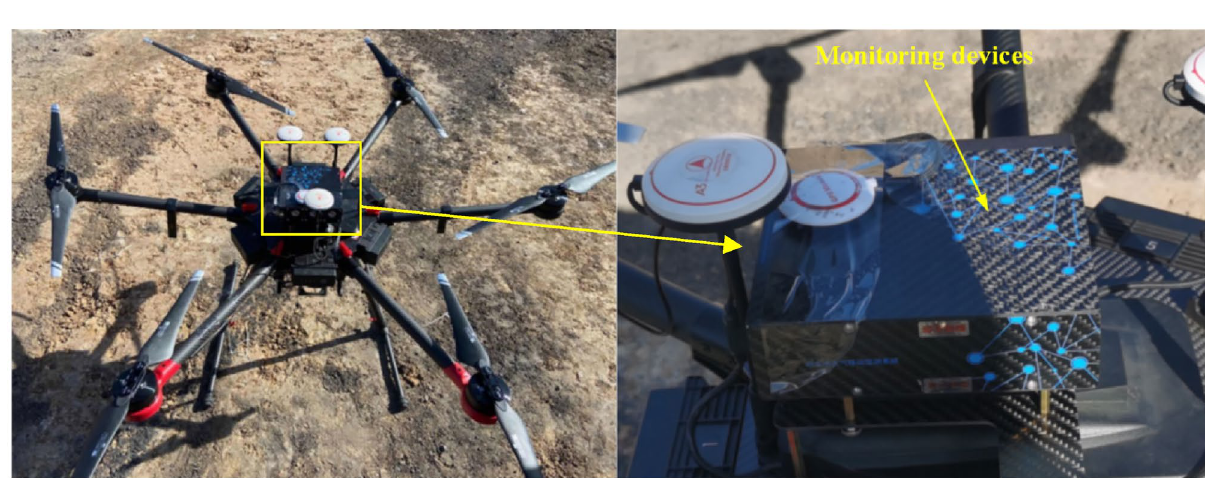
Figure 3. DJI M600pro with monitoring